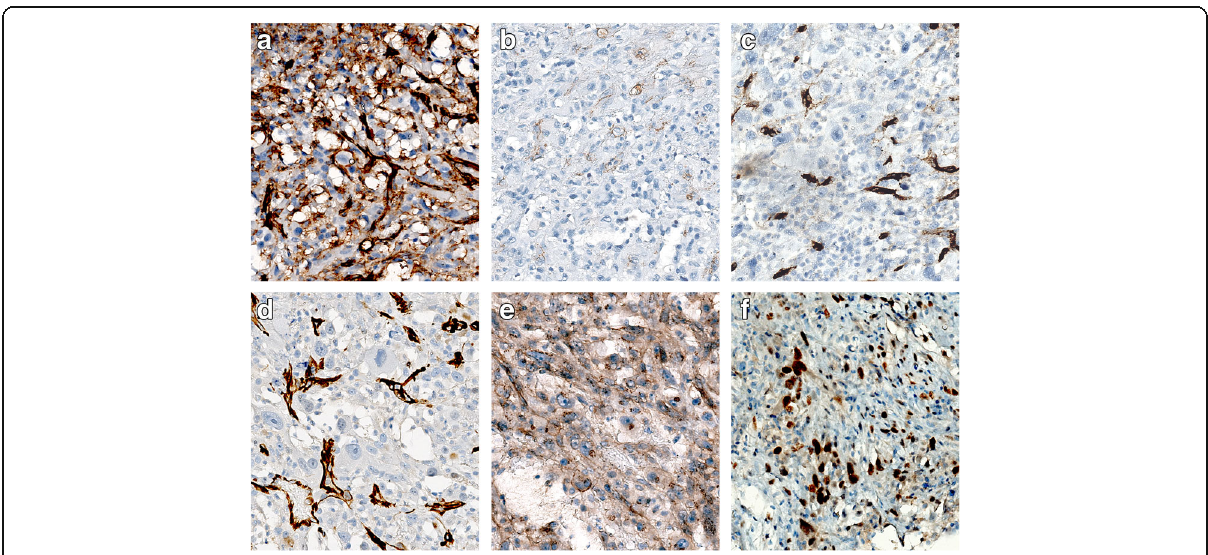
Fig. 4 a Positive immunostaining for CD31. b - c Negative immunostaining for CD34 ( b ) FVIII ( c ) and WT1 ( d ). A few non-neoplastic positive vascular spaces have been used as internal positive control. e Vacuolar/paranuclear positive pattern of CD99. f Positive nuclear immunostaining for c-MYC. a - f : 200×, immunoperoxidase